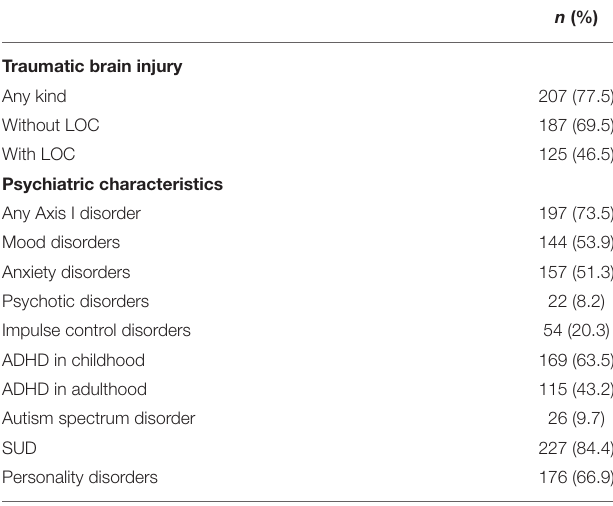
TABLE 1 | Prevalence of traumatic brain injury and psychiatric characteristics of young male violent offenders ( n 269). =